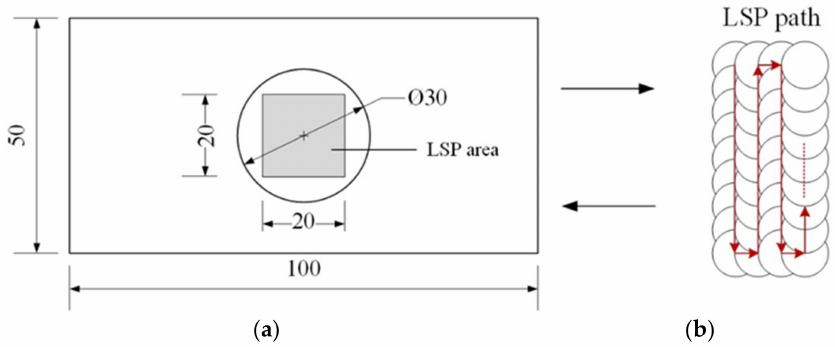
Figure 2. ( a ) LSP treatment area, and ( b ) LSP scanning